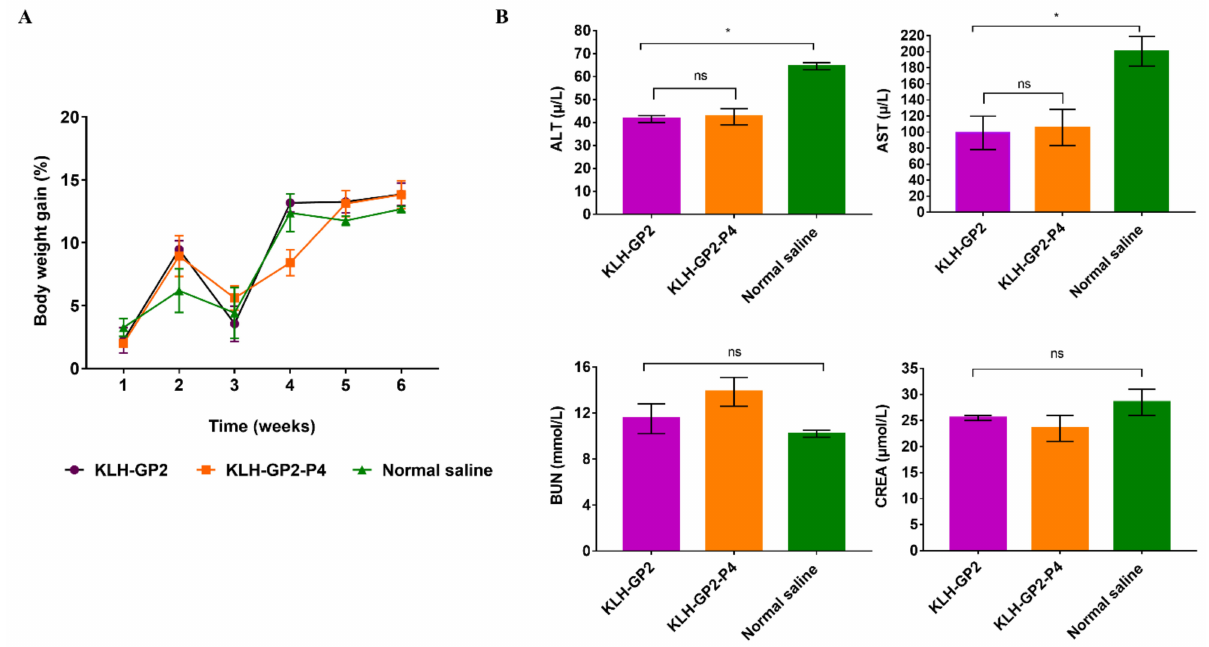
Figure 4. ( A ) Average percentage of weekly measurements of mice body weight during the immunization schedule. ( B ) Serum biochemical parameters (ALT, AST, BUN and CREA) of immunized BALB/c mice. Data presented as mean ± SEM. (* p < 0.05, and ns: p > 0.05) denote significant different as compared to control